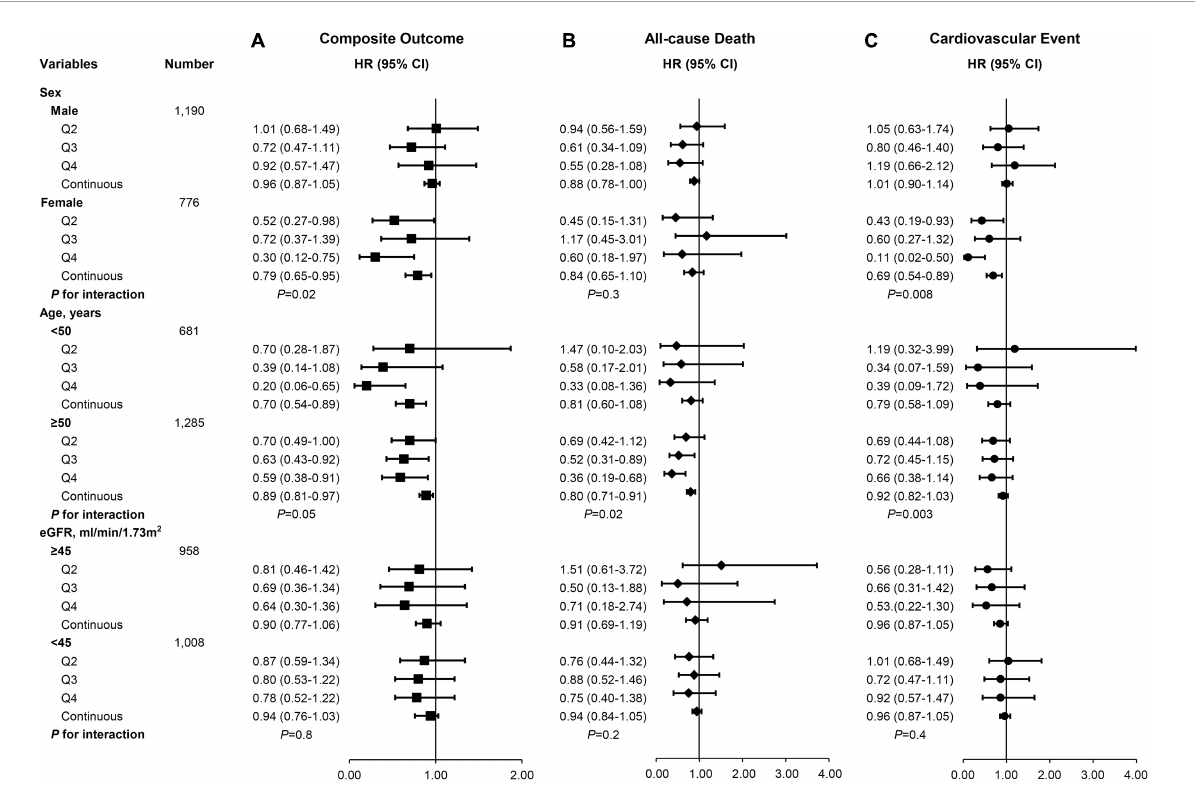
FIGURE3 There were different risks of (A) composite outcomes, (B) all-cause death, and (C) cardiovascular events according to subgroups in the multivariable-adjusted Cox proportional hazards model (Model 2).